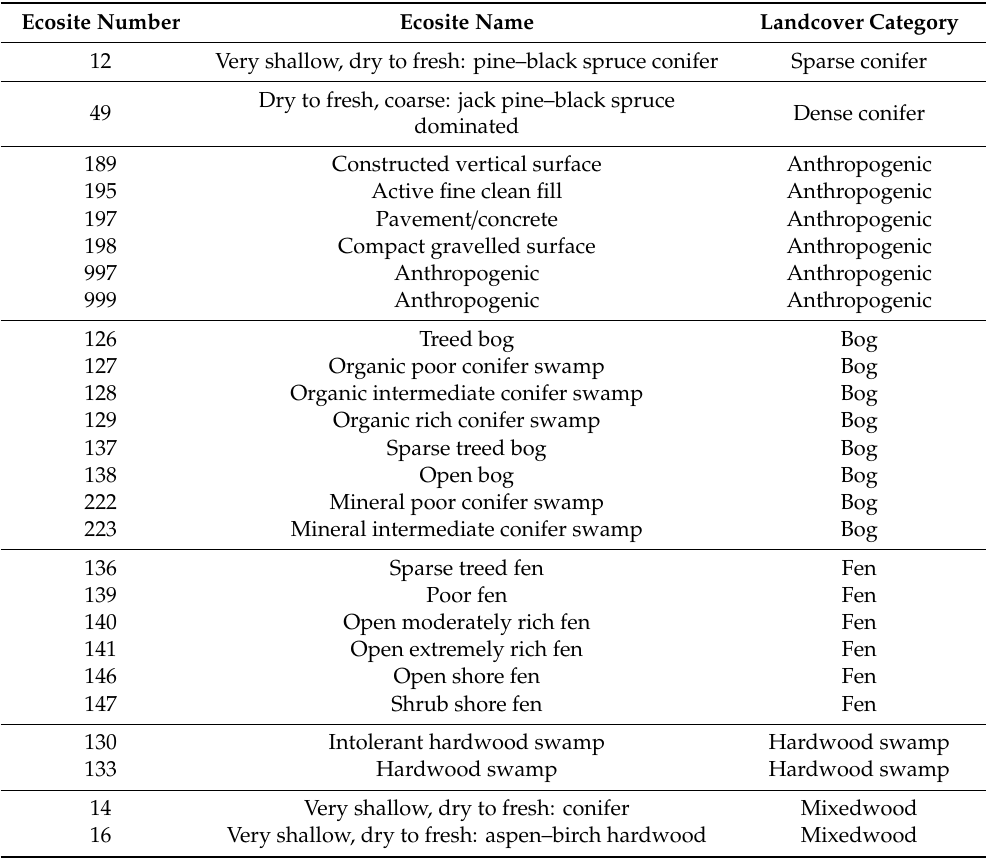
Table A3. Categorization of boreal ecosites of Ontario [12] into eleven categories used to model lichen presence and lichen abundance for the study